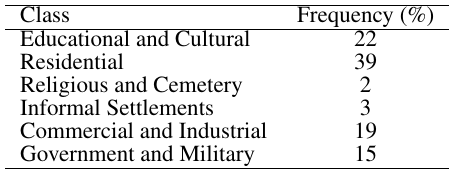
Table 1. Land use class frequency averaged over the whole set of image tiles